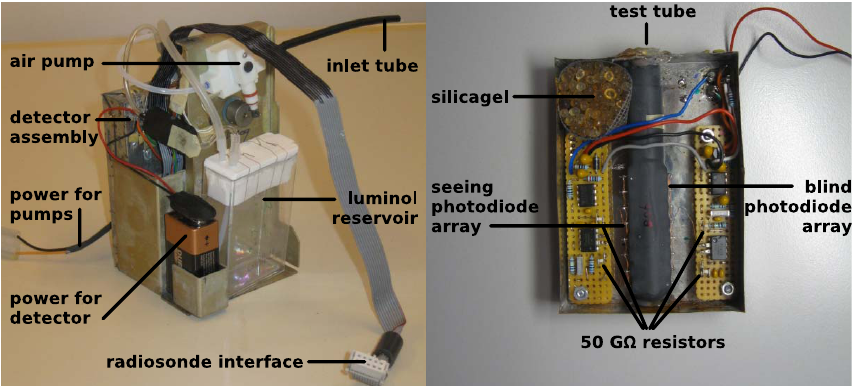
Fig. 1. The left panel shows all the components of an NO 2 sonde without light protecting material. The right panel is a close-up of the detector.